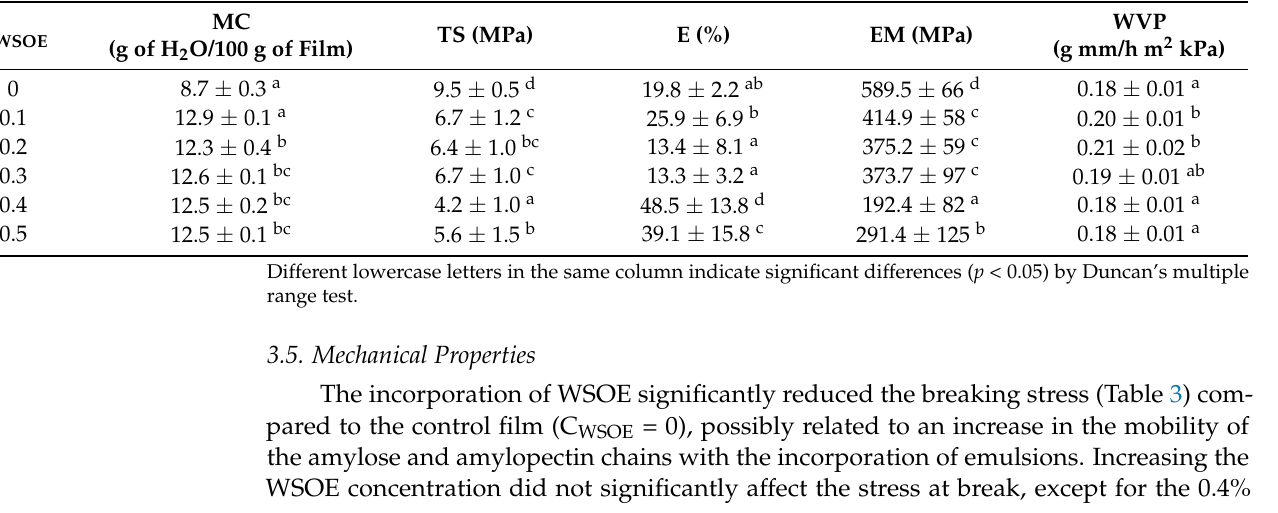
Table 3. Effect on moisture content (MC), tensile strength (TS), elongation (E), elastic modulus (EM), and water vapor permeability (WVP) of cross-linked cassava starch-based films with